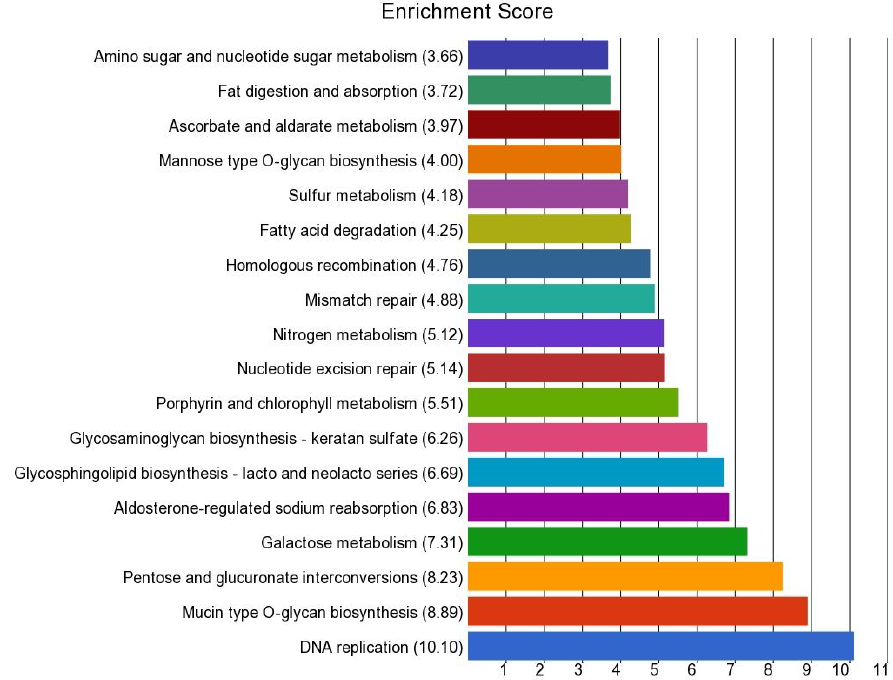
Figure 7. Enrichment score of the list of genes that had a significantly different magnitude of differential expression in CRC tissue than normal tissue, depending on the presence or absence of MSI.